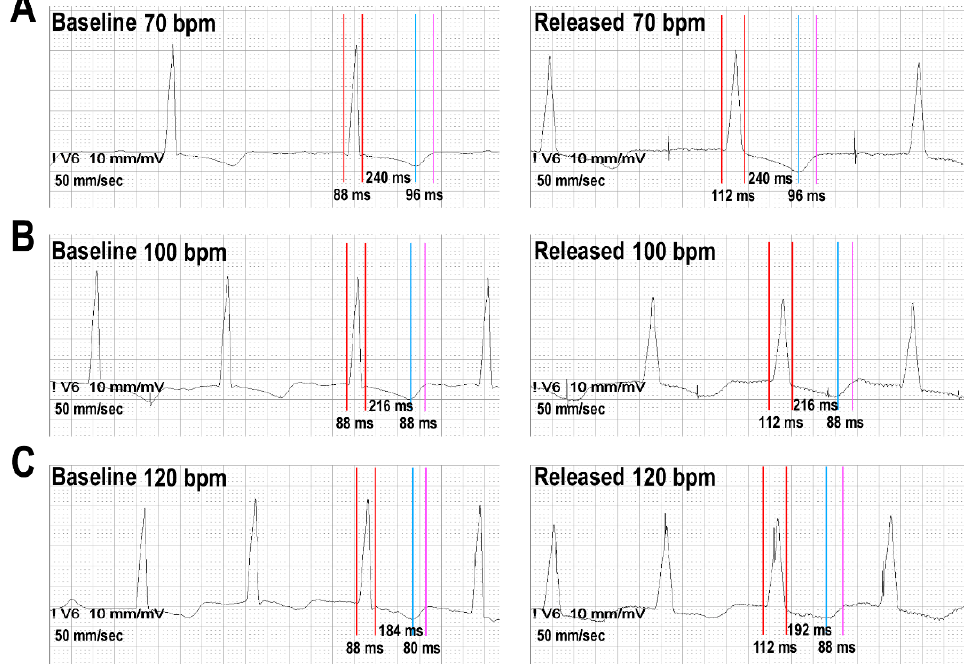
Figure 2. Example of measurements and behavior of ECG intervals.